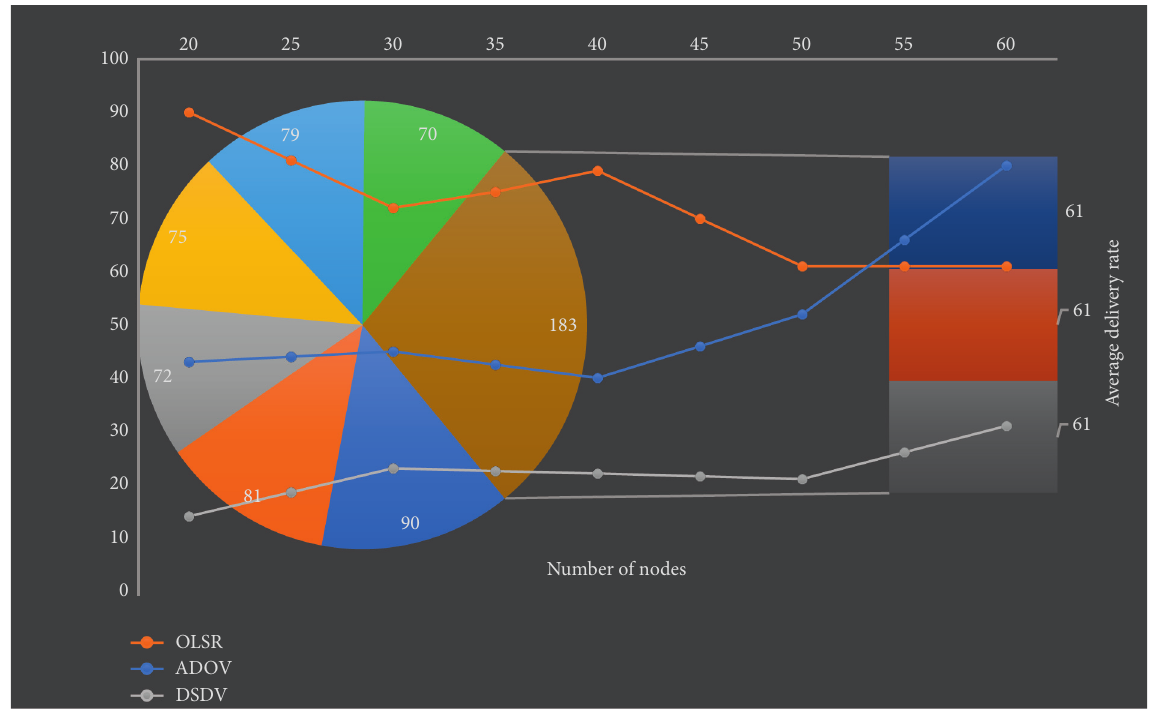
Figure 3: Average PDR.